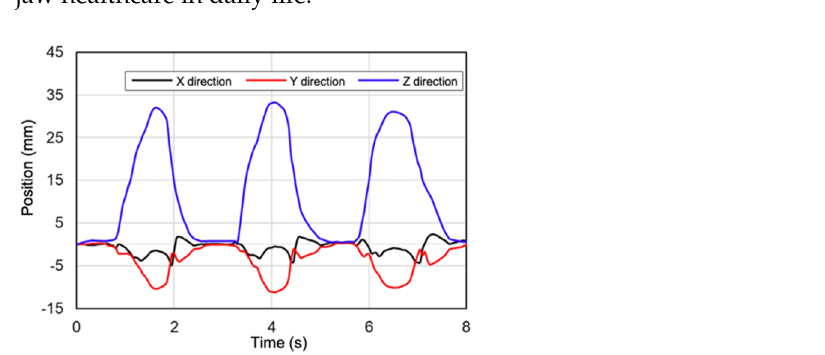
Figure 16. Time development of the estimated position during the patient’s maximum mouth open- ing.